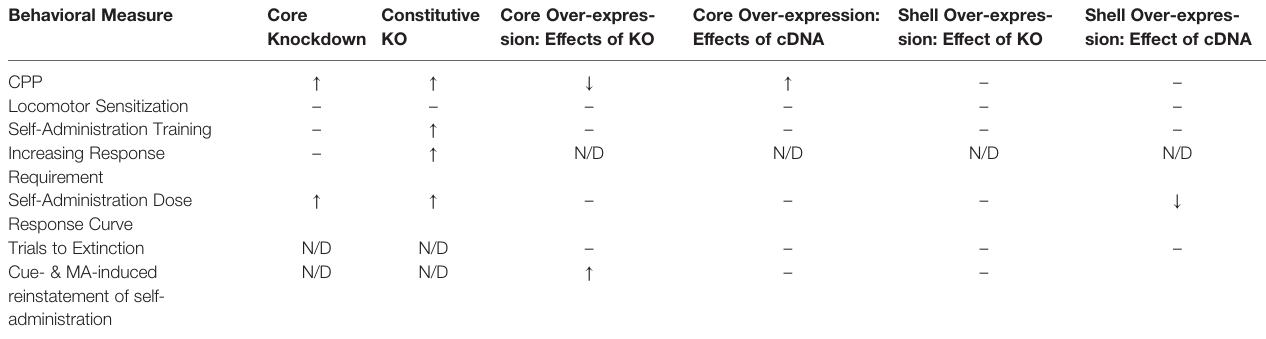
TABLE 1 | Summary of the results of the present